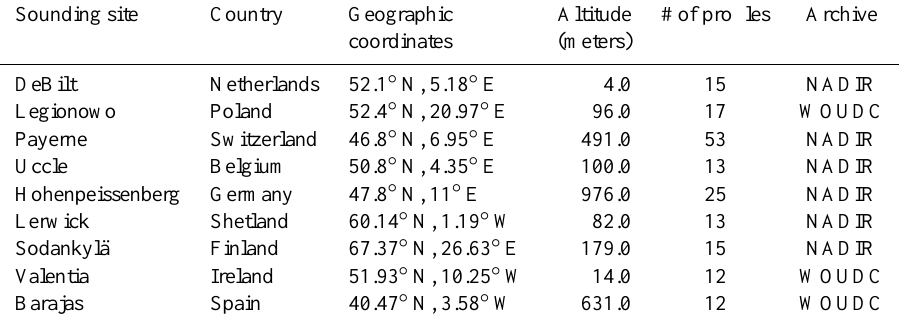
Table 1. Geographical characteristics of the sounding sites as well as the number of profiles available for the study. The sondes used in this paper are taken from two archives, namely (1) the World Ozone and Ultraviolet Data Center (WOUDC) (http://www.woudc.org) and (2) NILU’s Atmospheric Database for Interactive Retrieval (NADIR) at Norsk Institutt for Luftforskning (NILU) (http://www.nilu.no/nadir/). Sounding site Country